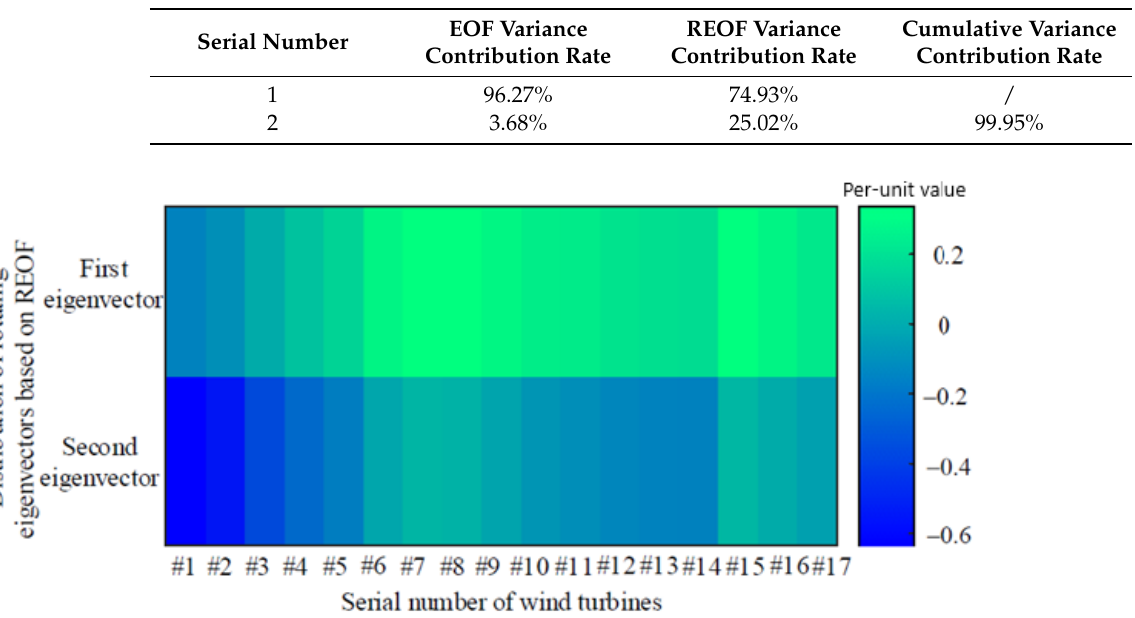
Figure 5. Heat map of load vector field spatial distribution based on